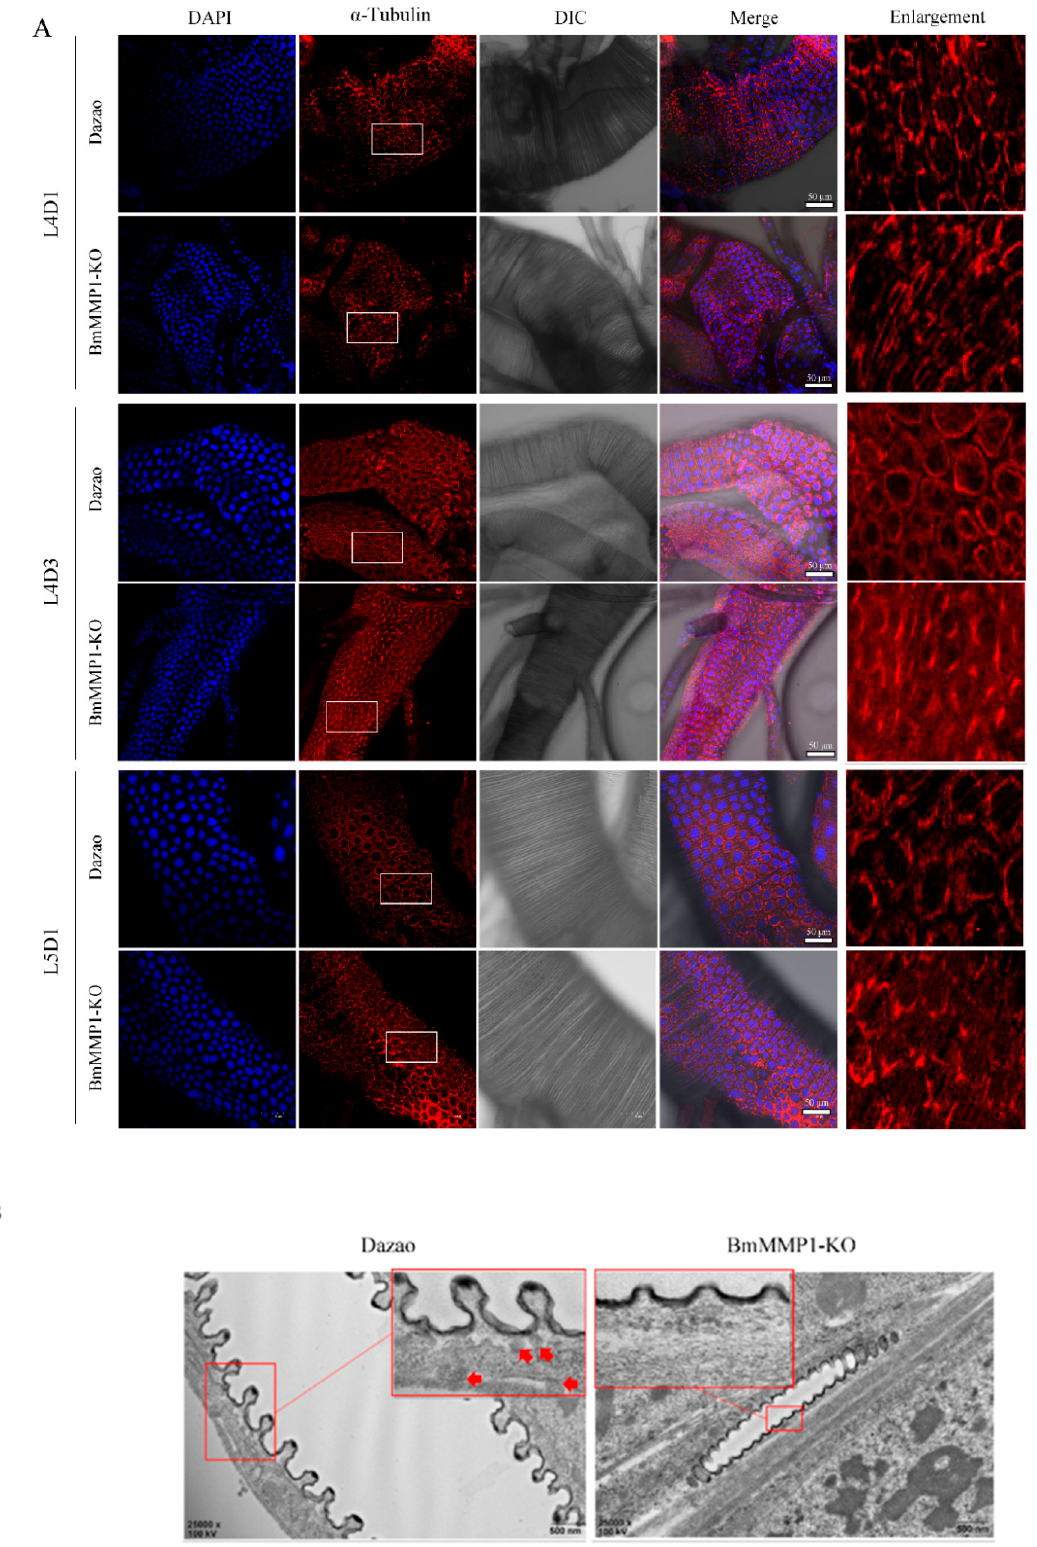
Figure 4. Knockout of BmMMP1 decreases epidermal cell spacing and breaks the structure of apical membrane in trachea. ( A ) Immunofluorescence assay of trachea in L4D1, L4D3, and L5D1. DAPI (Blue) stained cell nucleus, α -Tubulin (Red) stained cytoskeleton. ( B ) Remodeling of tracheal apical membrane observed by TEM. The big red box is a magnification of the small box and the red arrows indicate apical membrane protrusions.